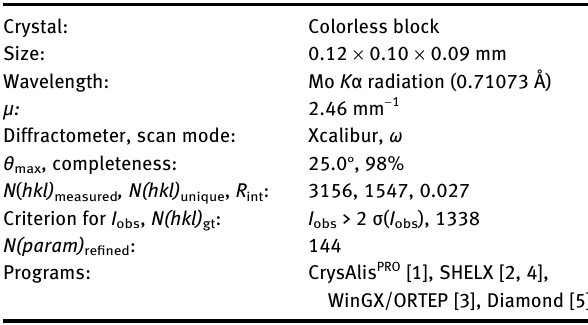
Table 1 contains crystallographic data and Table 2 contains the list of the atoms including atomic coordinates and displacement parameters.